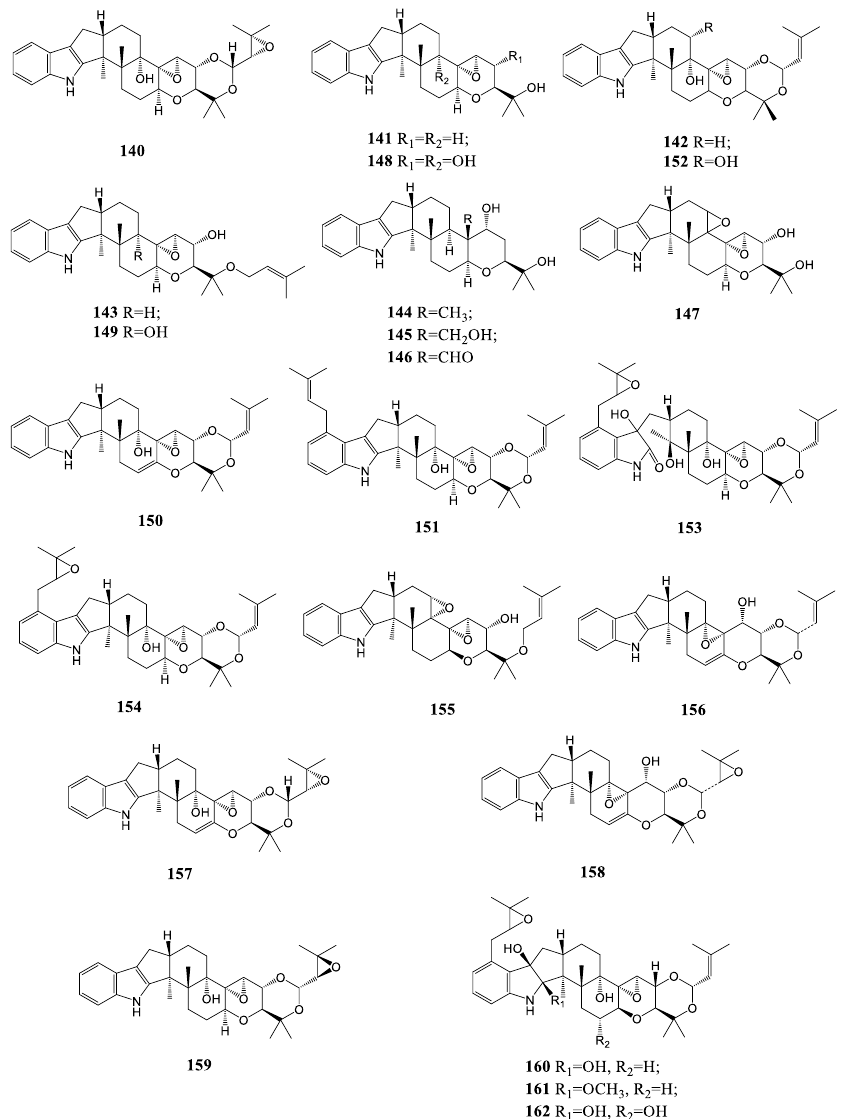
Figure 7. Terpendole-like indole diterpenoid compounds.